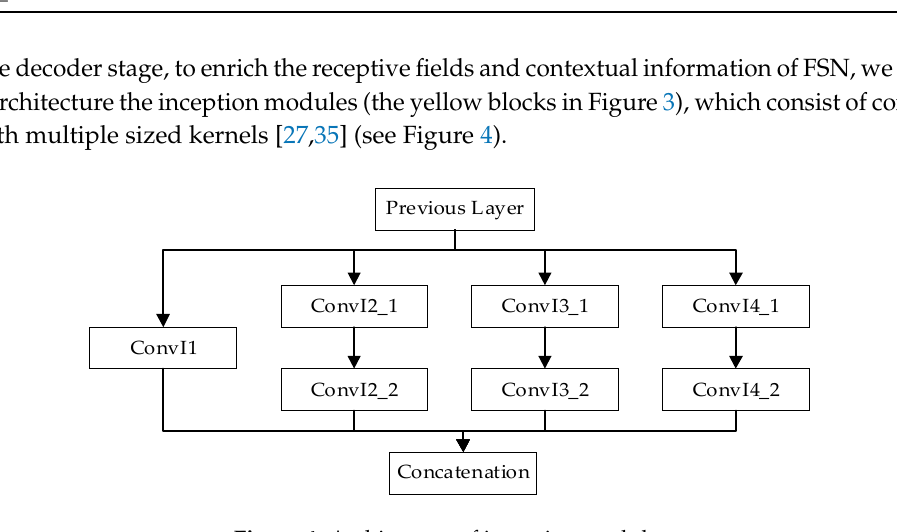
Figure 4. Architecture of inception module.